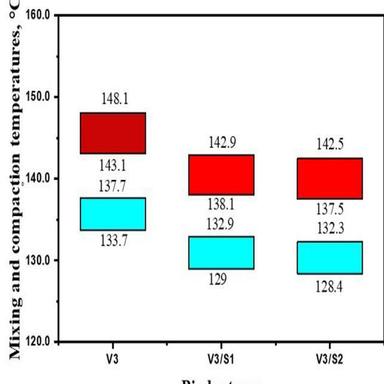
Ranges of mixing and compaction temperatures for the three asphalt